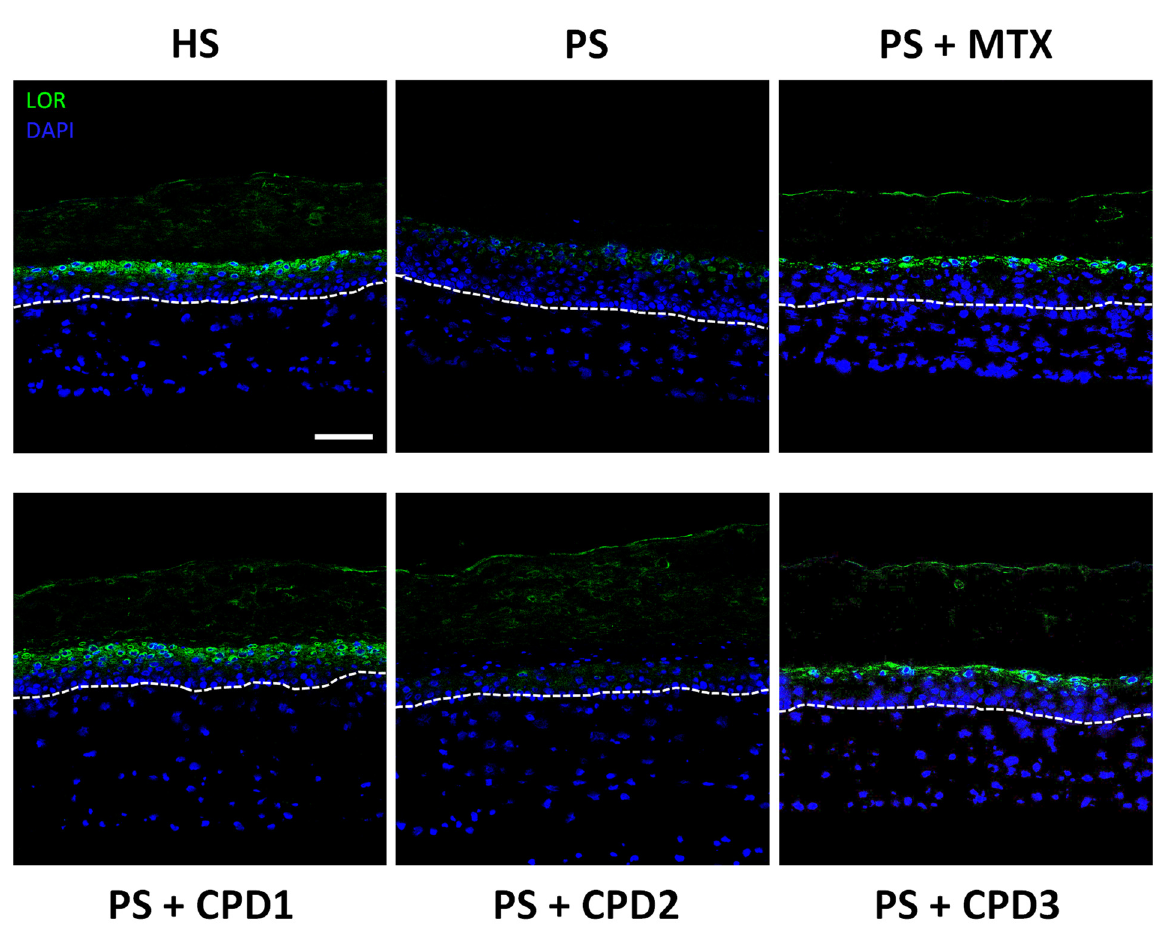
Figure 5. Immunofluorescence staining of a late differentiation marker (loricrin, green). Expression of loricrin (LOR) in healthy substitutes (HSs); psoriatic substitutes (PSs); and psoriatic substitutes treated with methotrexate (MTX), quebecol (CPD1), ethyl 2,3,3-tris(3-hydroxy-4-methoxyphenyl)propenoate (CPD2) and bis(4-hydroxy-3-methoxyphenyl)methane (CPD3). Nuclei were stained with Hoechst (blue). The dotted white line represents the dermo-epidermal junction. Scale bar: 50 µ m. Each staining is representative of three different cell populations.